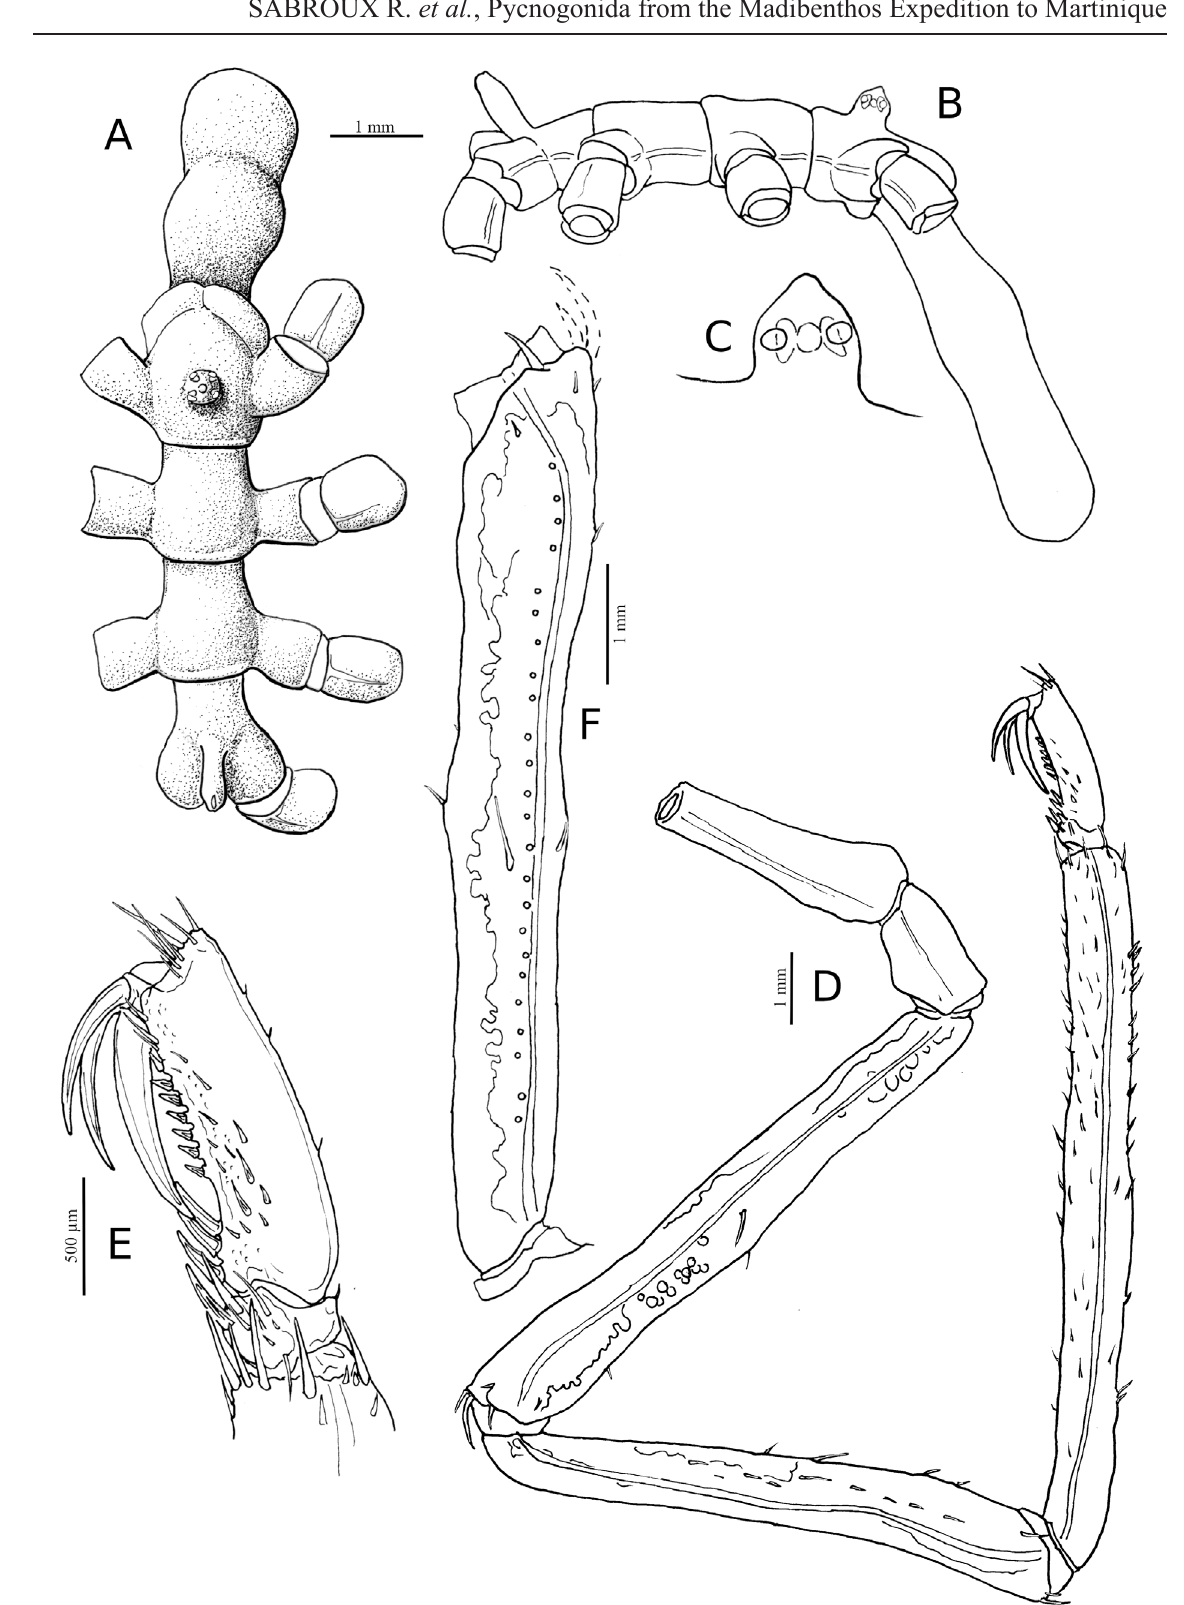
Fig. 19. Endeis sp. 3. A–E . ♀, MNHN-IU-2016-863. F . ♂ , MNHN-IU-2016-1203. A . Body, dorsal view. B . Body, lateral view (same scale as A). C . Ocular tubercle, lateral view. D . Leg. E . Tarsus and propodus. F .